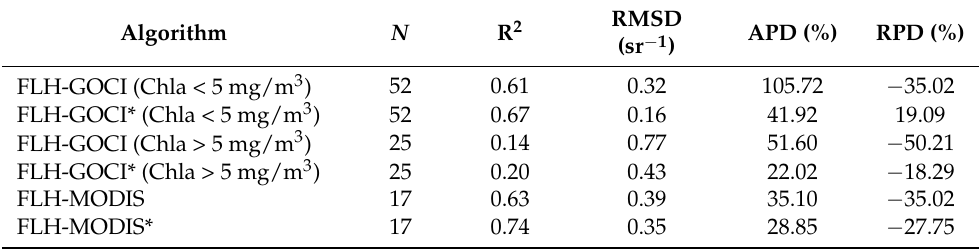
Figure 7. Scatter plots of measured data and calculated FLH results from ( a ) GOCI and ( b ) MODIS (FLH-GOCI: FLH result calculated by using the GOCI original band; FLH-GOCI*: FLH algorithm result of GOCI in this study; FLH-MODIS: FLH value calculated by using the MODIS original band; FLH-MODIS*: FLH calculation result of MODIS in this study). Table 3. Results of FLH algorithm performance validated using the measured datasets.